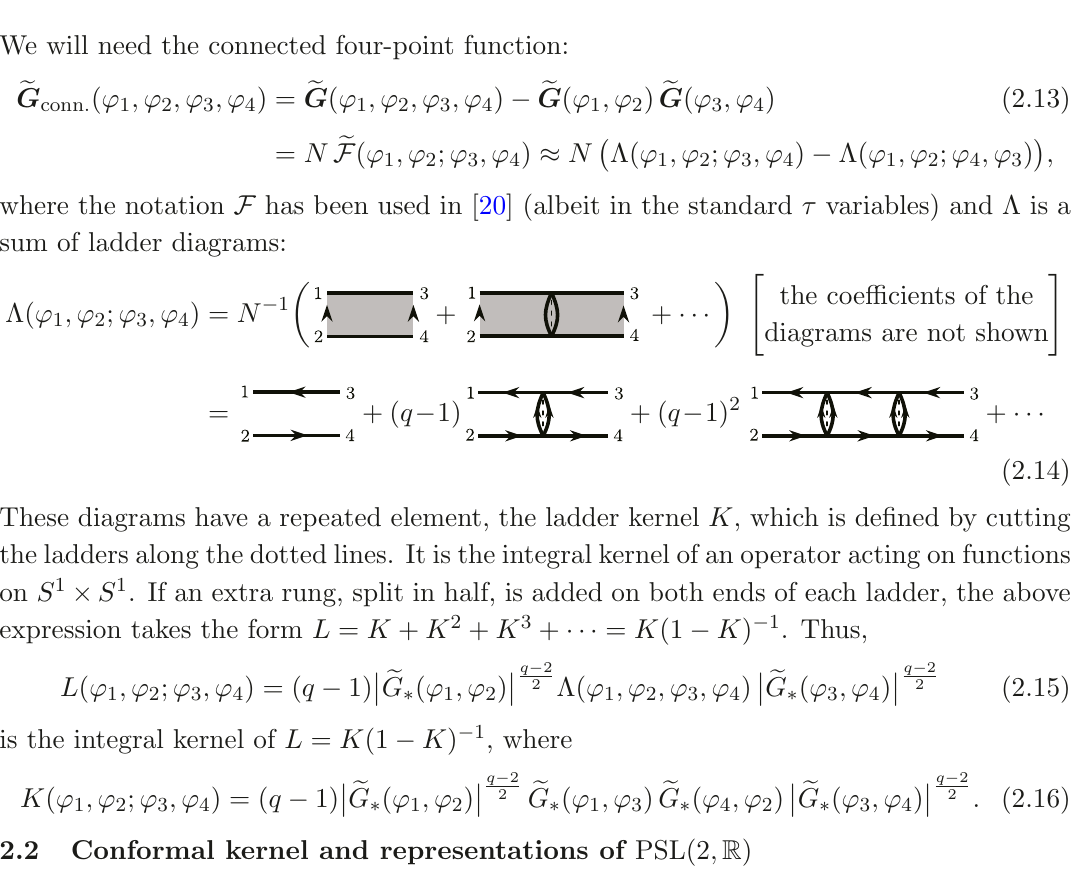
G ∗ may be attached directly to the template e